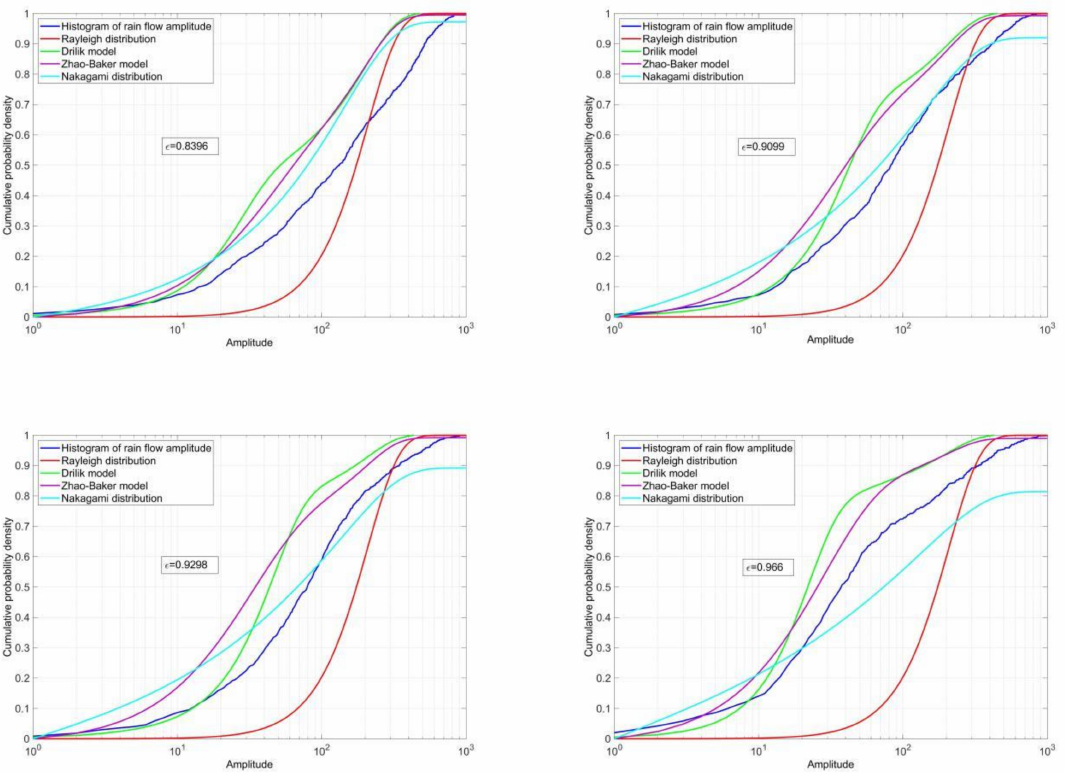
Figure A6. Rain flow amplitude CDF (multi-peak spectrum).